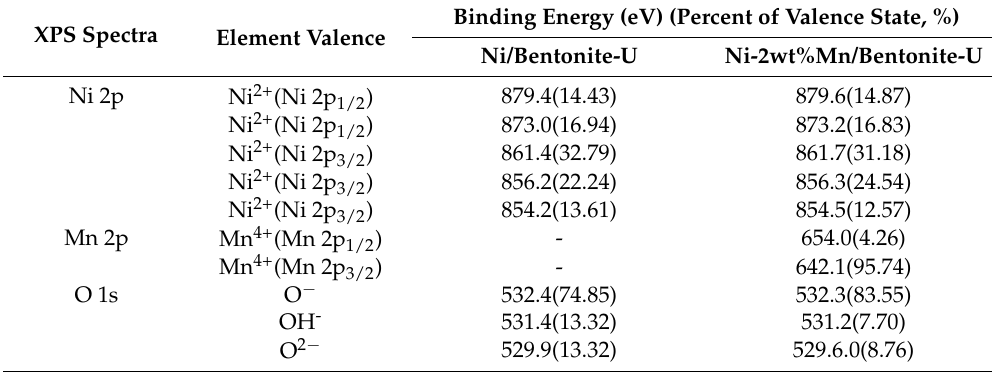
Figure 6. XPS spectra of Ni 2 p , Mn 2 p , and O 1 s regions for Ni/bentonite-U ( a ) and Ni-2wt%Mn/bentonite-U ( b ) catalysts. Table 2. Binding Energy of Ni 2 p , Mn 2 p , and O 1 s for Ni/bentonite-U and Ni-2wt%Mn/bentonite-U